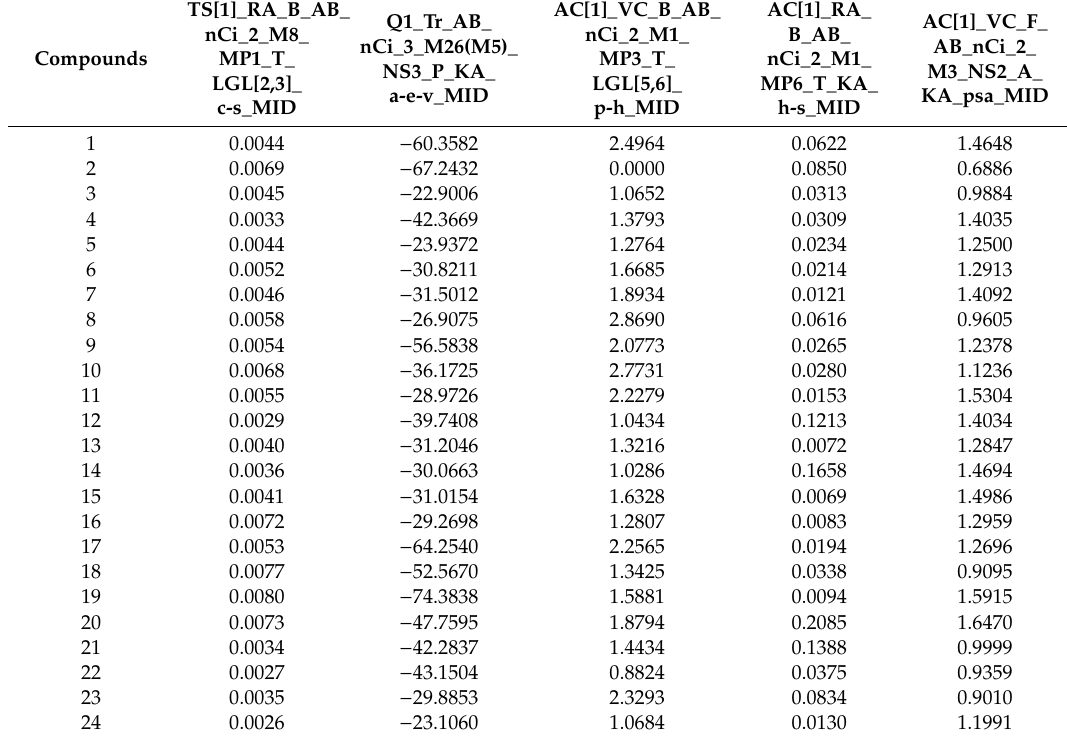
Table 3. Five of the most important molecular descriptors involved in the activity against Staphilococcus aureus , XU212